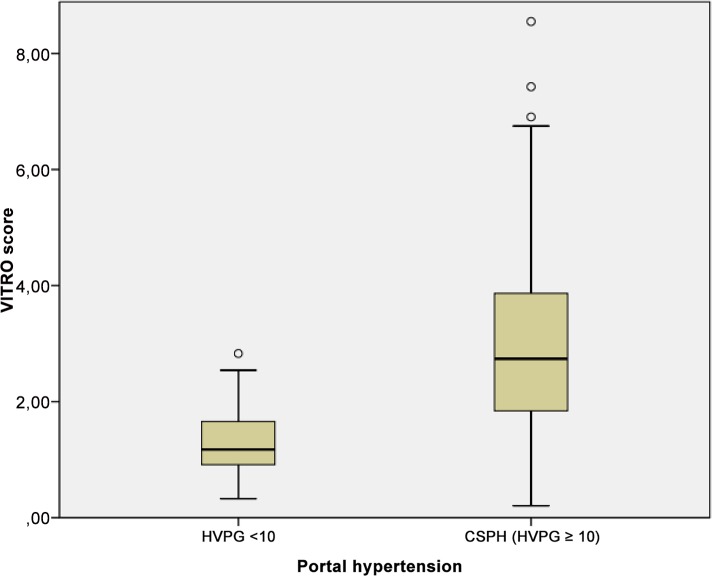
Correlation of VITRO (VWF-Ag/platelets) score and CSPH.Mean values of VITRO score shown in boxplots for a cohort of patients with and without CSPH each.